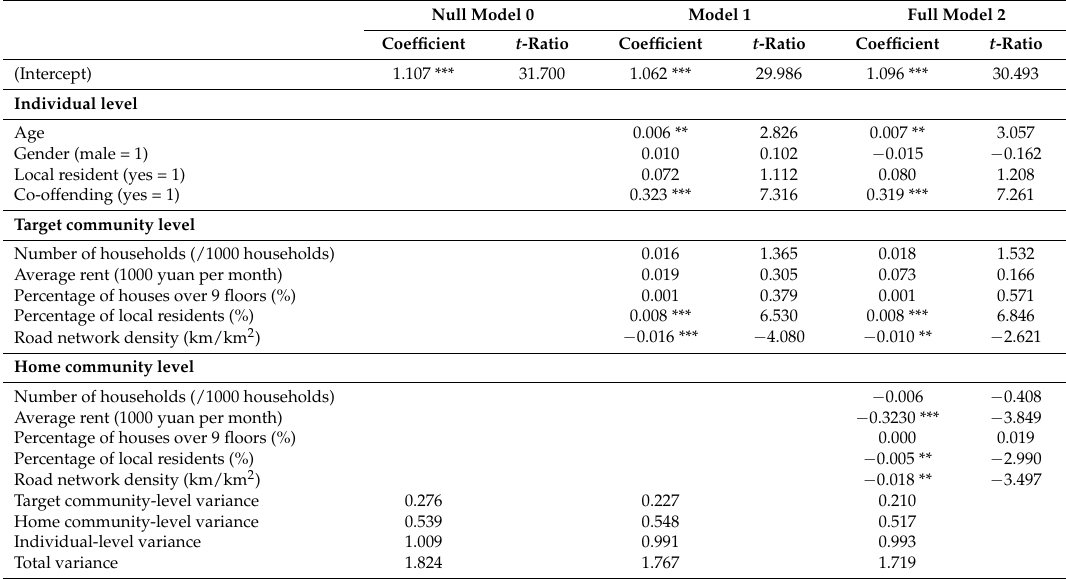
Table 2. Cross-classified multilevel models of (logged) journey-to-crime